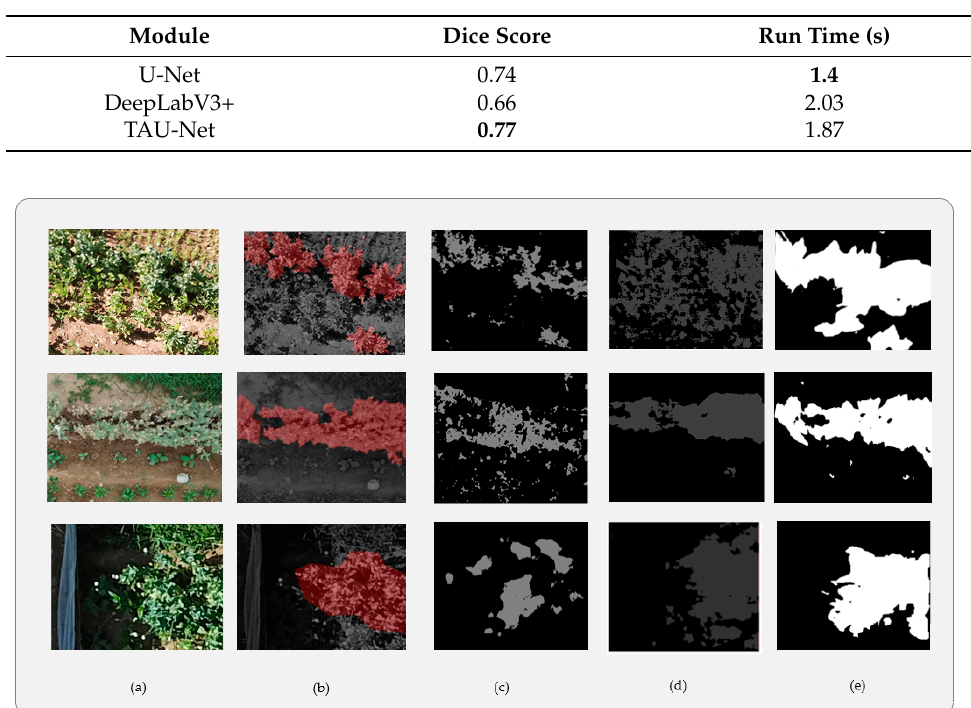
Figure 5. ( a ) Poppy image, ( b ) ground truth and segmentation masks of: ( c ) U-Net, ( d ) DeepLabV3+, ( e ) TAU-Net (with PRE).